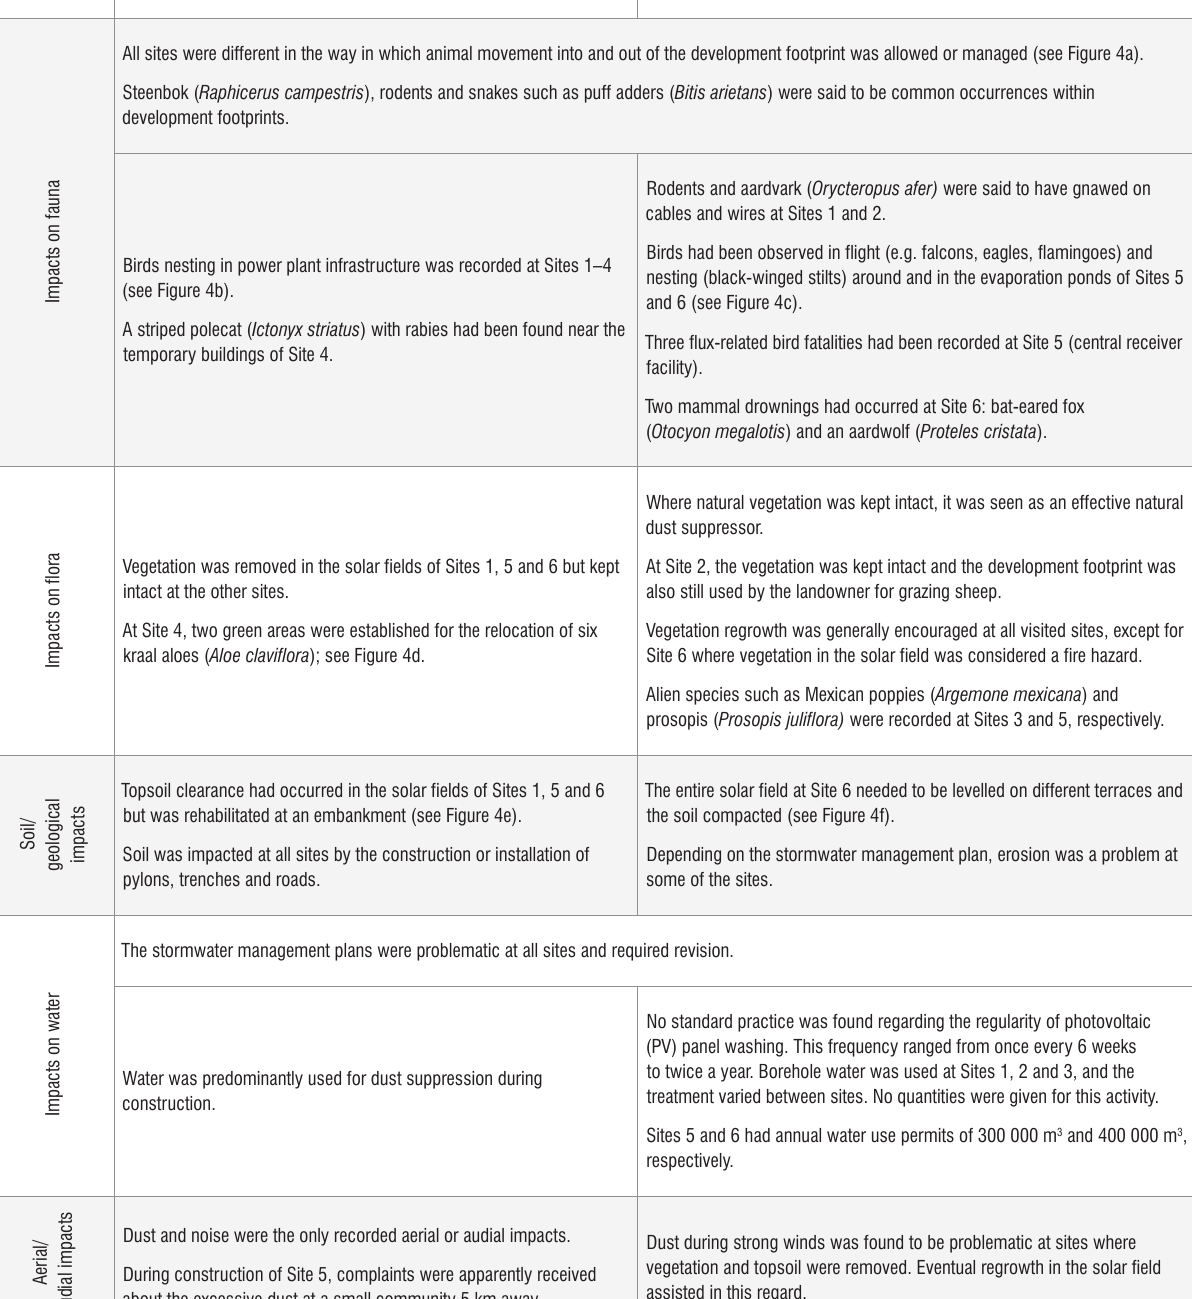
Selected key findings from the site visits per impact category. Findings are arranged as associated with either construction or operational activities. Impact